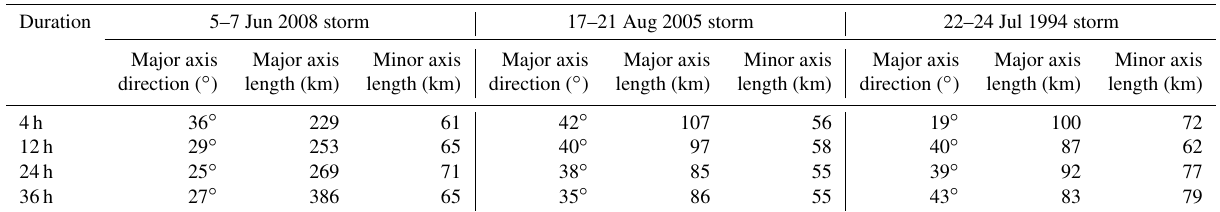
Figure 12. Trend surfaces and residuals of the total rainfall amounts: (a) and (b) show the 5–7 June 2008 storm; (c) and (d) show the 17–21 August 2005 storm; (e) and (f) show the 22–24 July 1994 storm. Table 3. Directions and lengths of the axes of trend